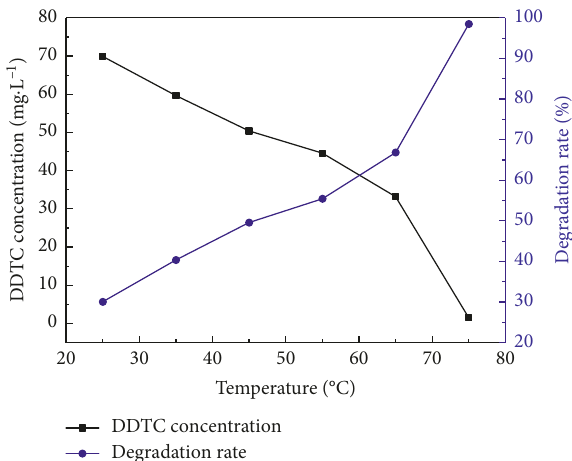
Figure 5: Influence of the temperature on the degradation of DDTC.